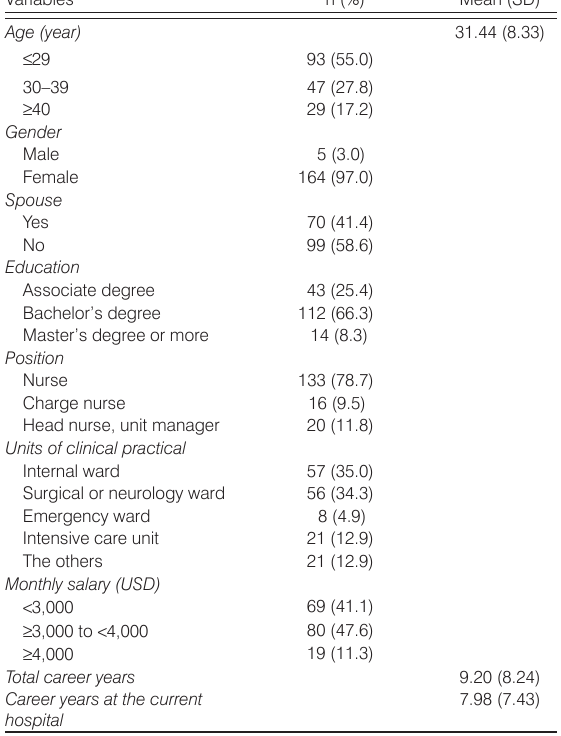
Table 1. General